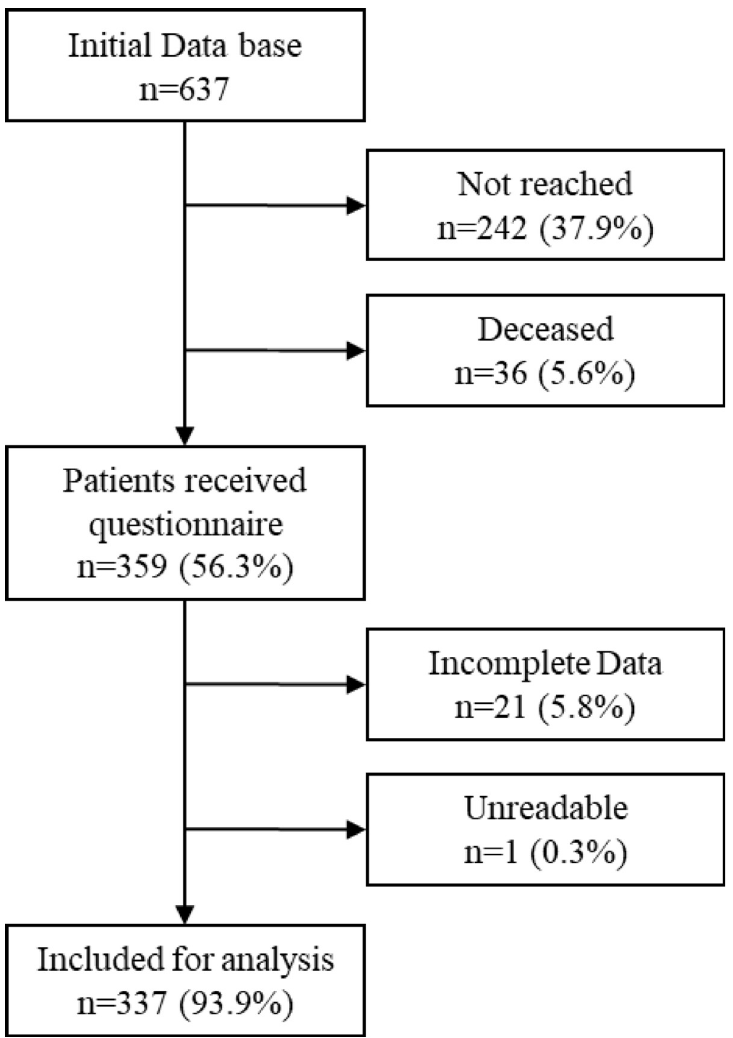
Fig 1. Flow chart of inclusion process of study population. The initial database included XXX patients. The exhaustive process to contact patients included contacting regional administration offices (up to three different offices) to follow patients who